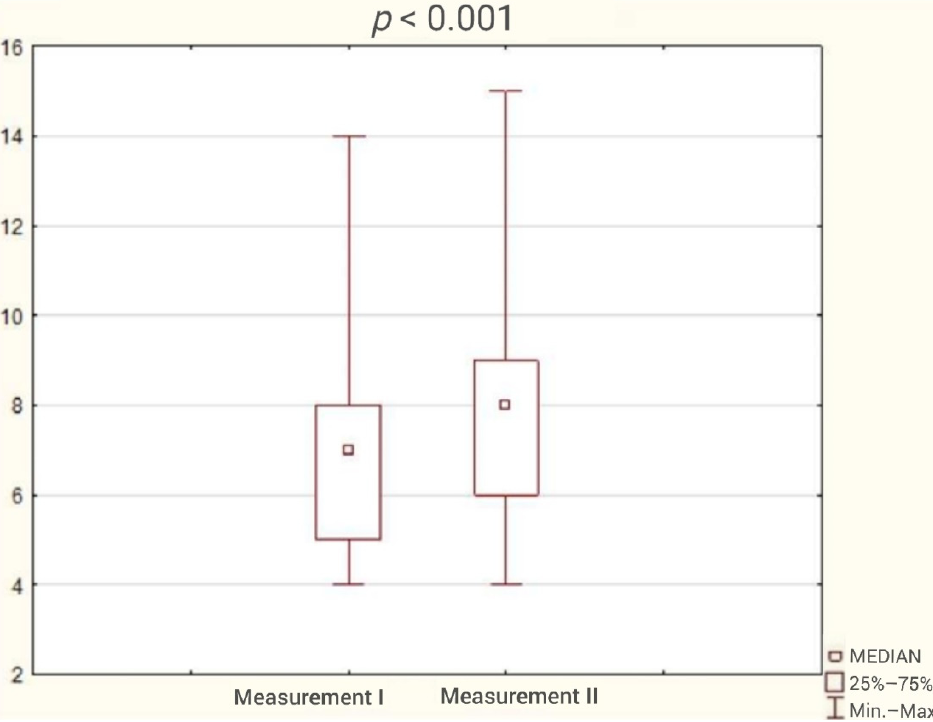
Figure 6. Patient result in digit repetition test during the first and second study (Wilcoxon test). No correlation was proved between sleep disorders and cognitive impairment nei- ther in the first and second study (Spearman’s rank correlation test; p > 0.05).